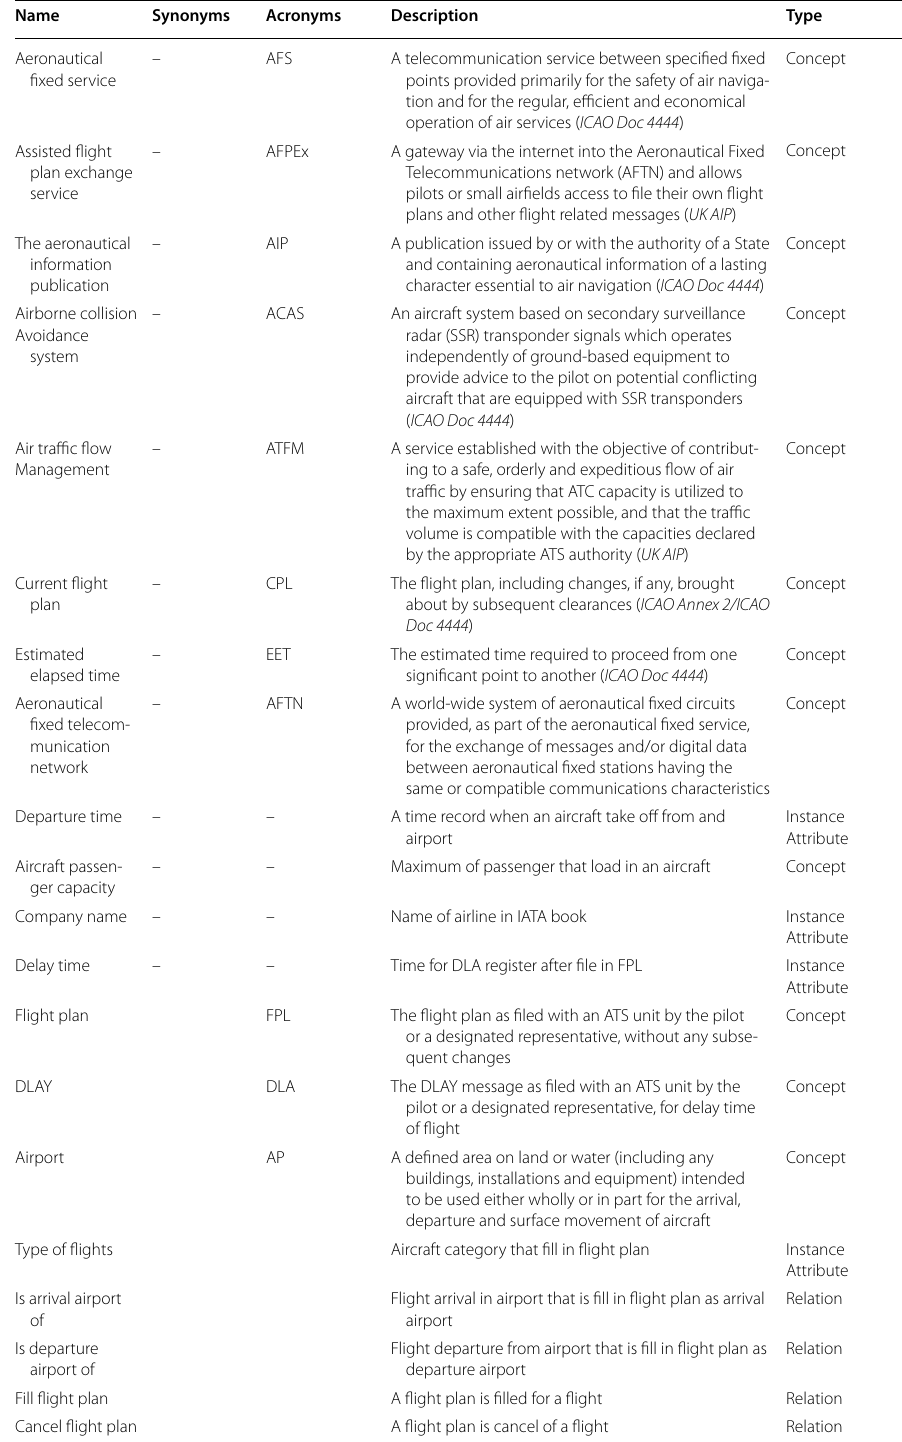
Table 2 Example of glossary of terms and